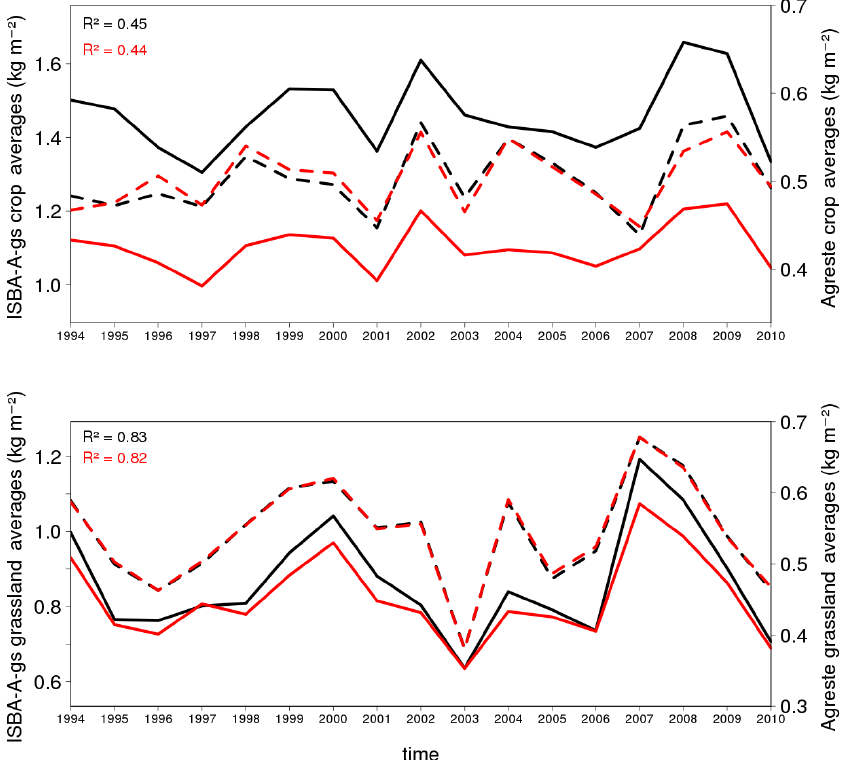
Figure 10. Averaged simulated yearly B ag values (ISBA-A-gs, solid lines) and averaged observed agricultural yields (Agreste, dashed X lines) for départements with significant correlations ( R 2 ) at the 1% level, with both FR-2L (black solid line) and DIF1-NRT (red solid line) simulations for (top panel) C3 crop GY and (bottom panel) grassland